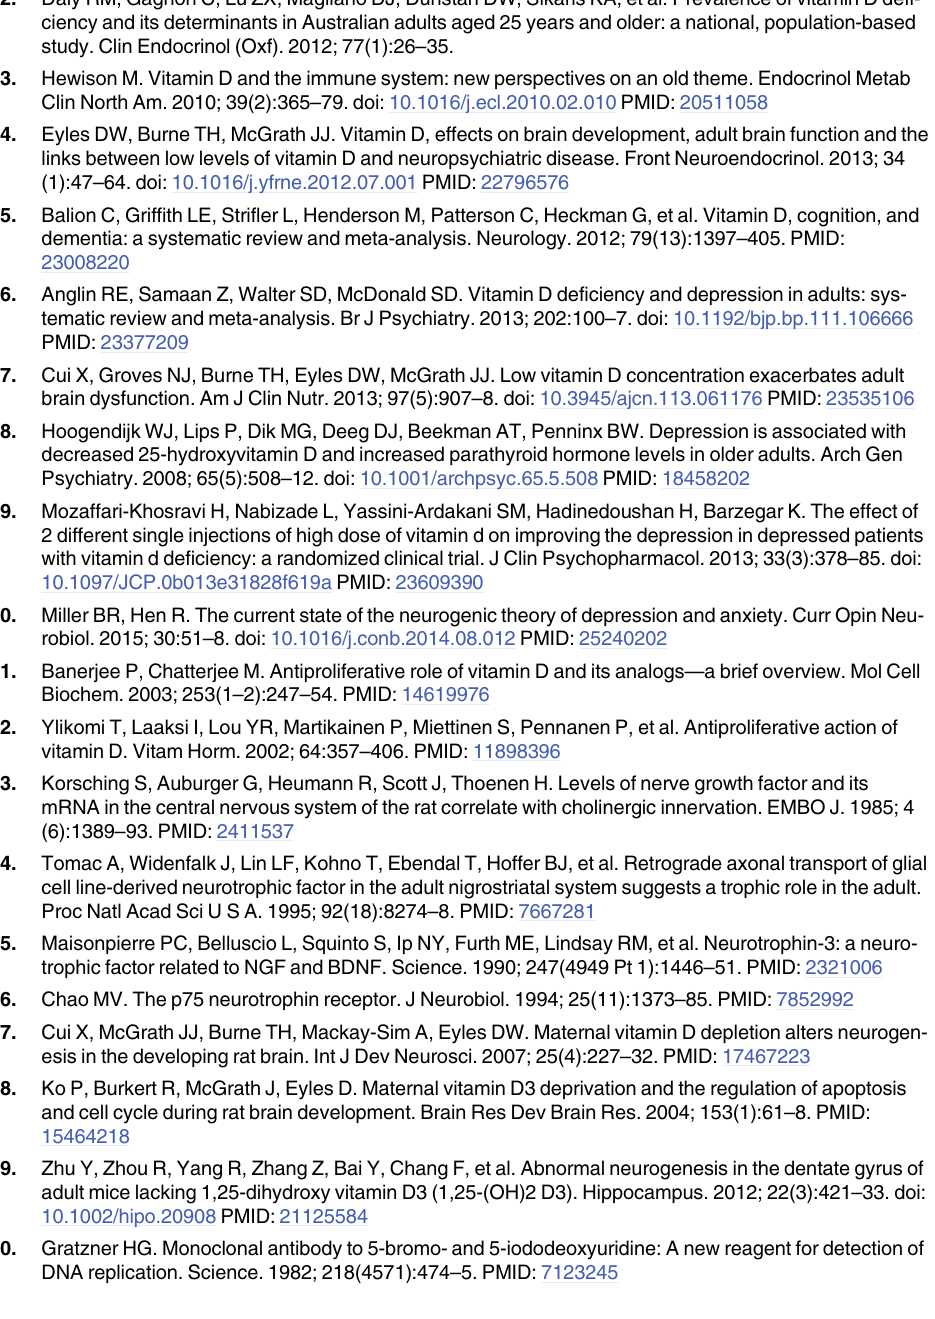
PLOS ONE | DOI:10.1371/journal.pone.0152328 April 4,